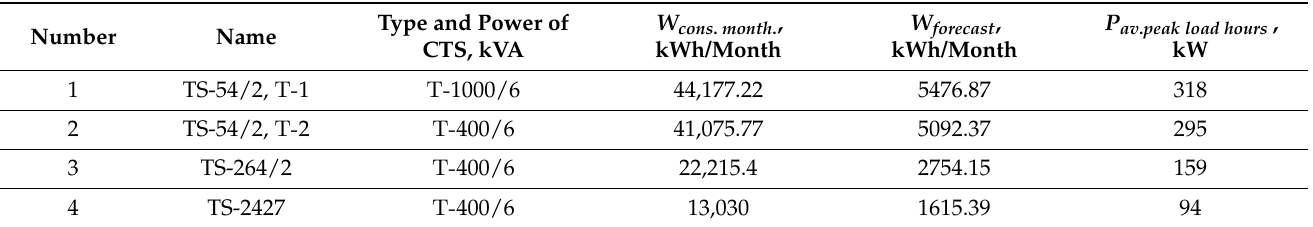
Table 2. Computation results of power consumption and average power during the hours of maxi- mum